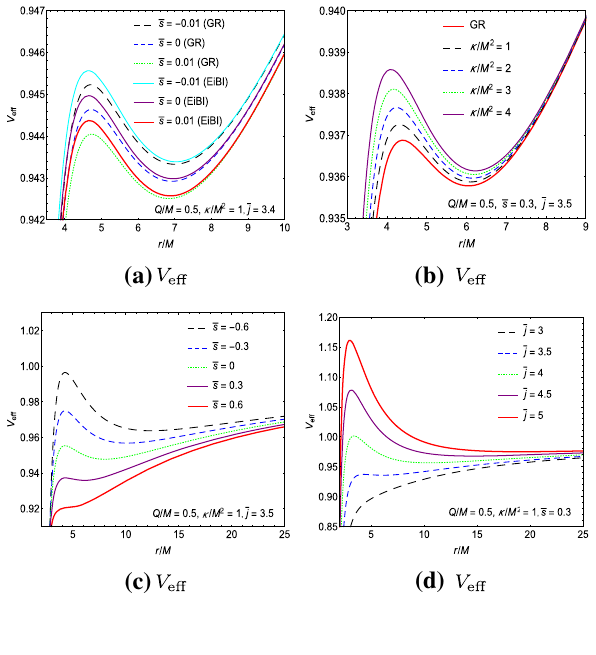
Fig. 2 The shapes of the effective potential V eff for different